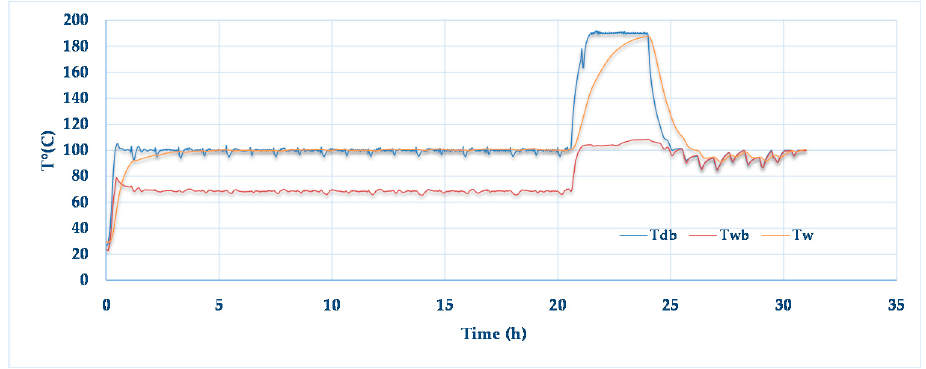
Figure 3. Evolution time of the temperatures during the thermal modification process at 190 °C. Tdb—dry-bulb temperature; Twb—wet-bulb temperature; Tw—wood temperature.